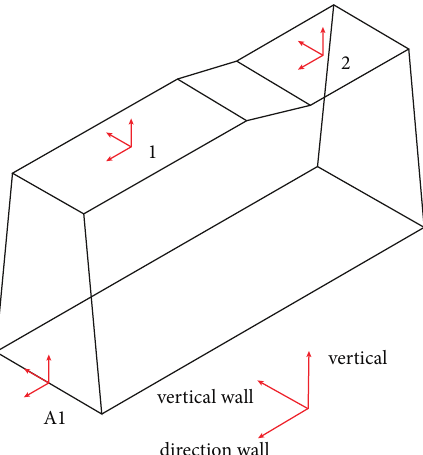
Figure 4: Distribution of measurement points. There are three measuring points in the model, and three sensors are placed at each point to measure three different